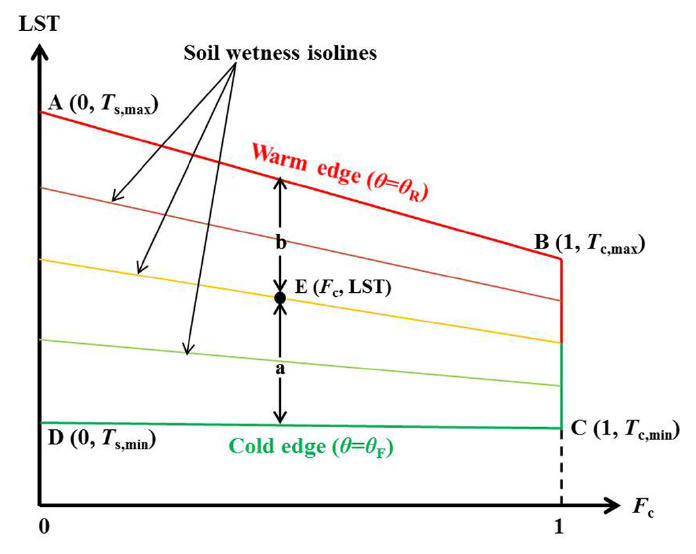
Figure 1. A sketch of the trapezoidal vegetation coverage/land surface temperature ( F c /LST) space. The nomenclature is given in Section